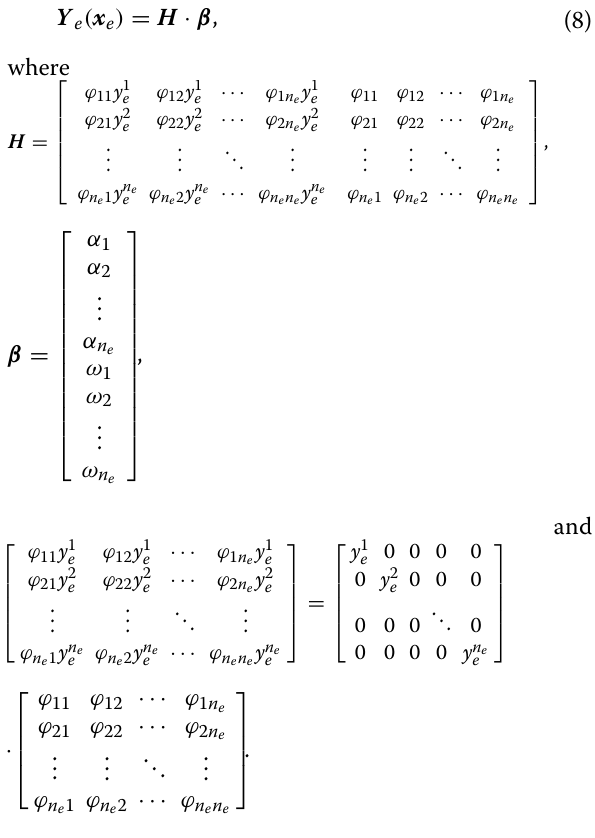
the remaining subsets were fitted for training